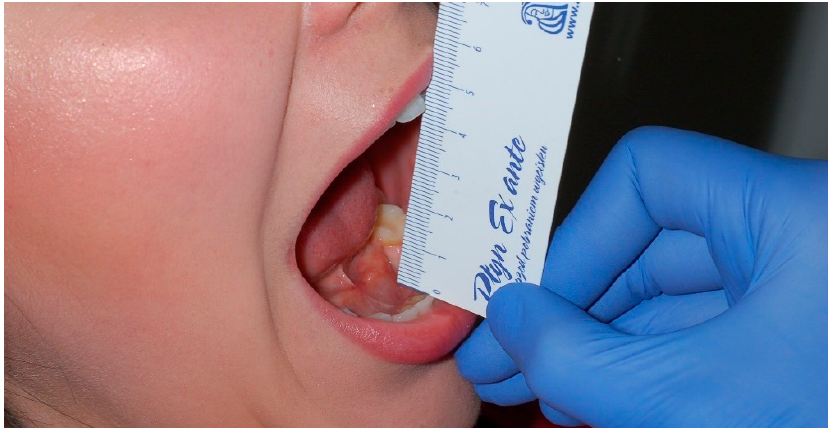
Figure 1. The measurement of the maximal interincisal distance.